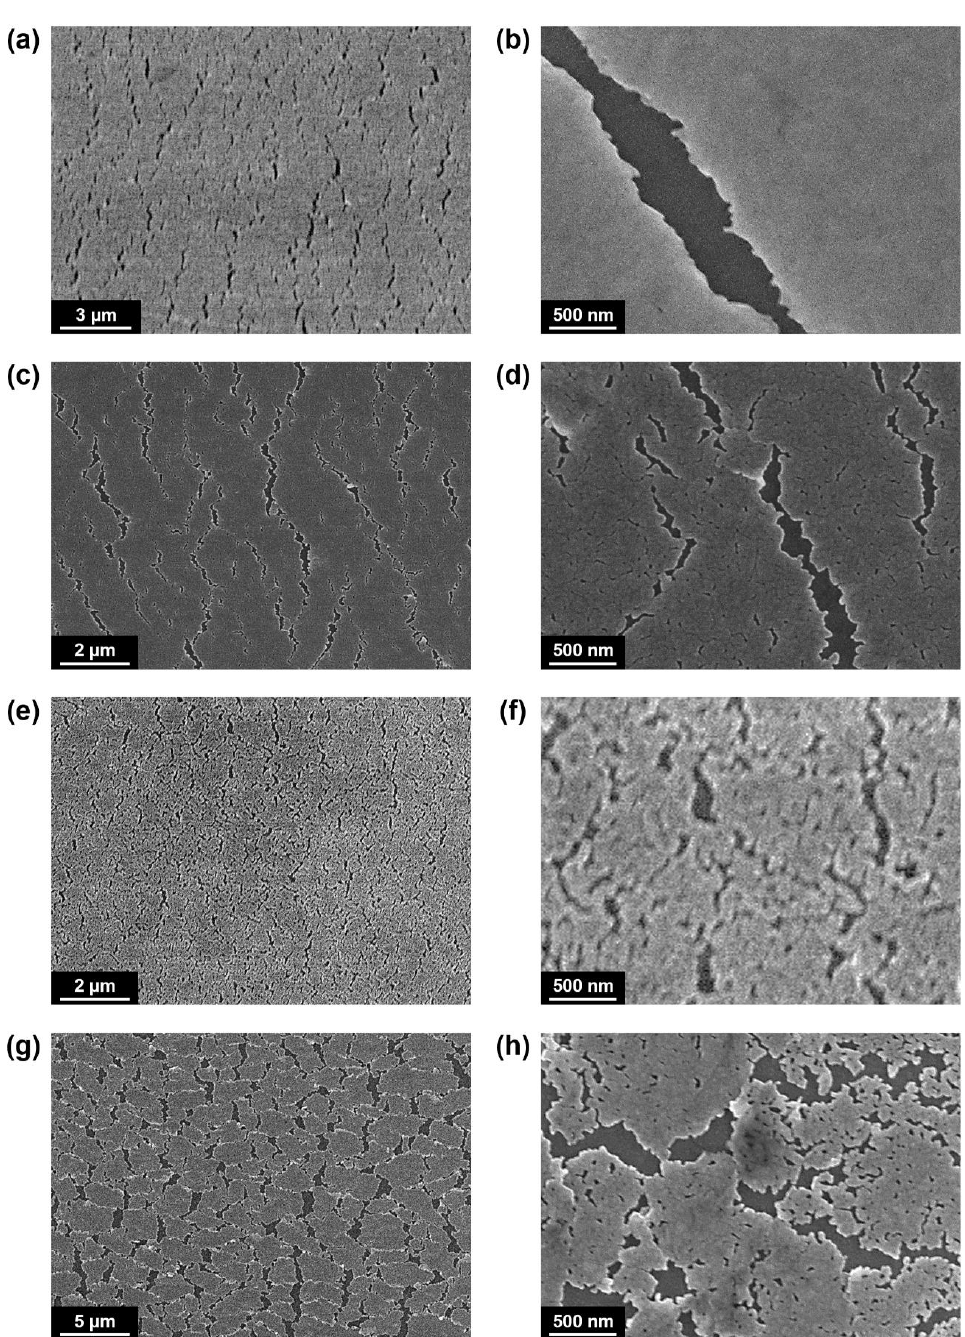
Figure 3. SEM images of the cracked Ag electrodes after completing the cold-welding processes. ( a , b ) SEM images of the UA120 sample. No further deformation of Ag was observed between crack lines as in ( b ). ( c , d ) SEM images of the UA140 samples. Minor cracks were further observed between major crack lines as in ( d ). ( e , f ) SEM images of the BA120 sample. Orientations of cracks were significantly diversified in comparison with the uniaxially stretched samples as in ( f ). ( g , h ) SEM images of the BA140 sample. The Ag film was divided into island forms as in ( g ), and minor cracks with a high density were clearly observed within the Ag islands as in ( h